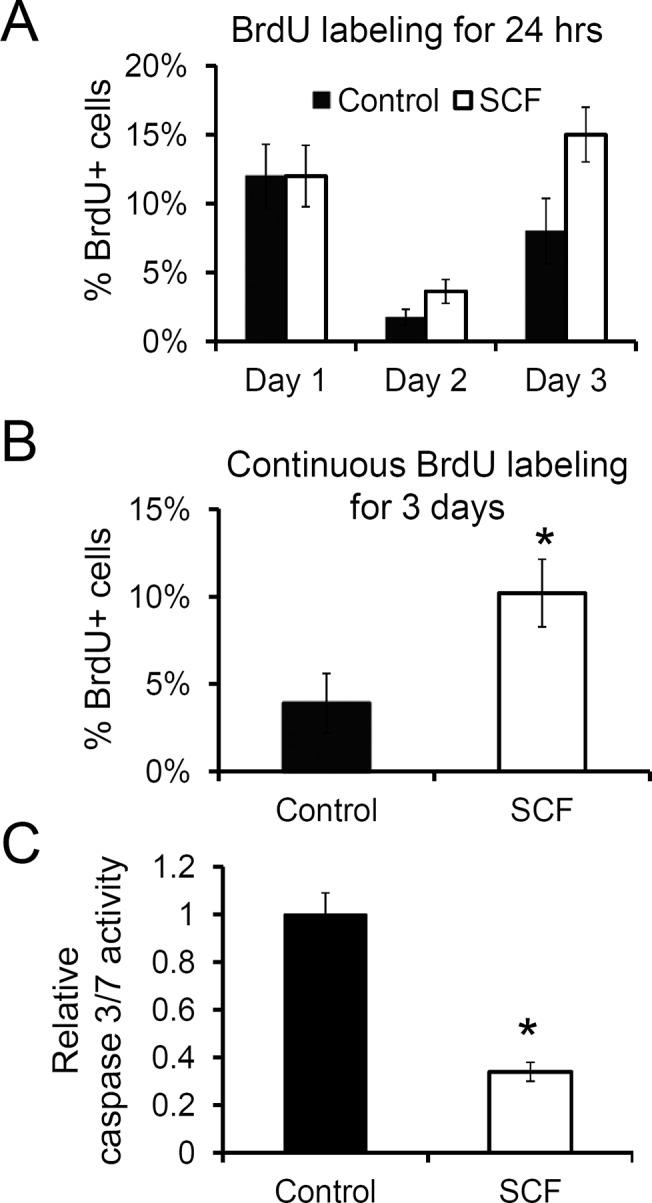
c-kit activation induces proliferation and decreases apoptotic cell death in CPCs.Human c-kit+ CPCs were serum starved for 24 hr and labeled with BrdU in the presence or absence of SCF for 24 hr only for the indicated day (A) or continuously for 3 days (B). Cells were stained with anti-BrdU antibody, and the positive cells were expressed as the percentage of total nuclei. C, CPCs were grown in serum free media for 3 days. Activities of caspases 3 and 7 were measured and normalized to the untreated control. Values presented are mean ± SEM. *, p<0.05.